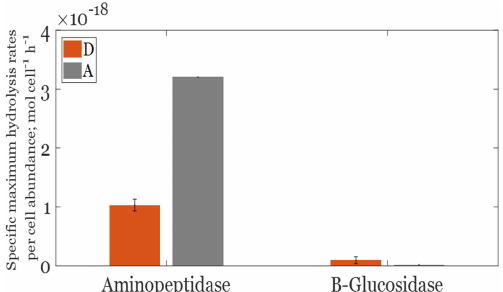
Figure 4. Cell-specific maximum aminopeptidase and β glucosi- dase hydrolysis rates per cell abundance in Saharan dust (orange bars) and anthropogenic (gray bars) aerosol treatments at the end of the incubation